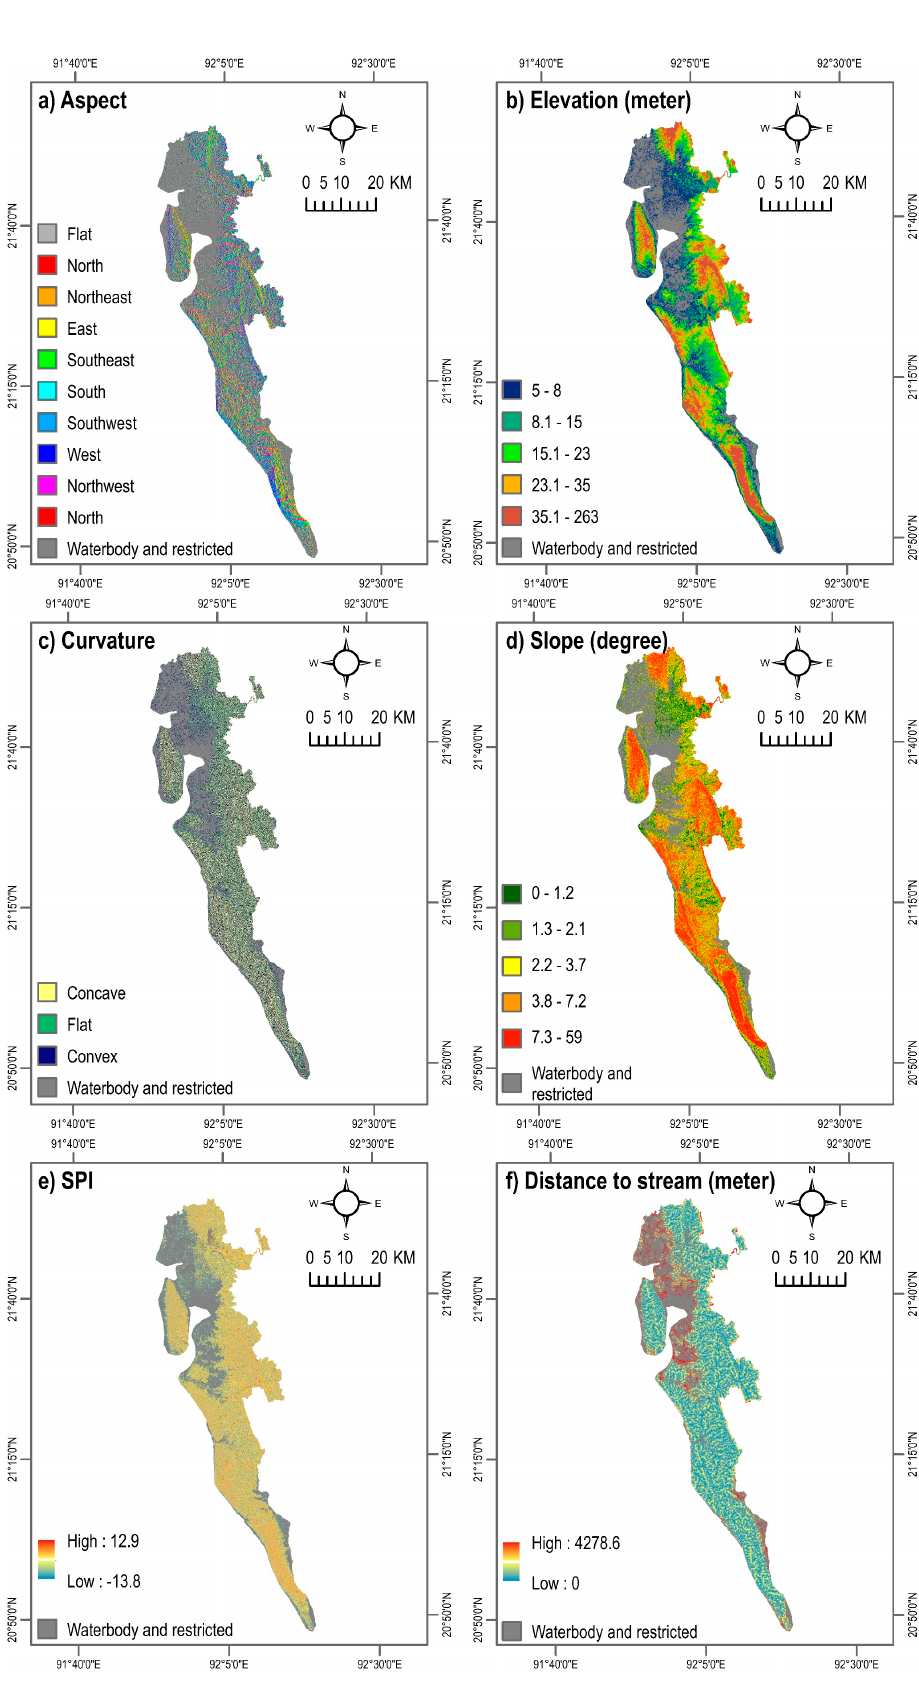
Figure 4. Landslide conditioning factors (SPI = Stream Power Index). Figure 4. Cont